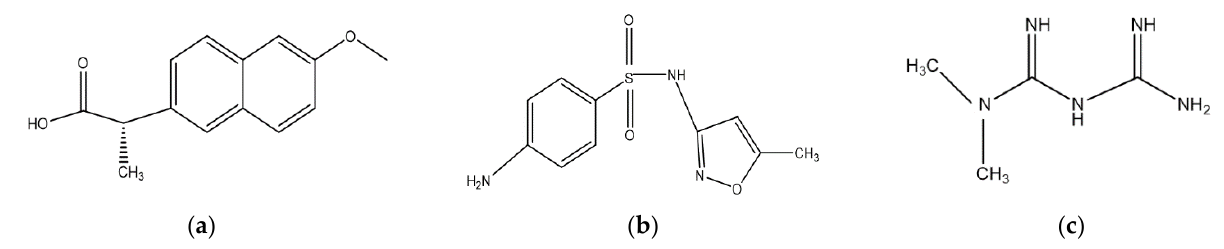
Figure 4. Structural structure of Naproxen ( a ), sulfamethoxazole ( b ) and metformin ( c ).